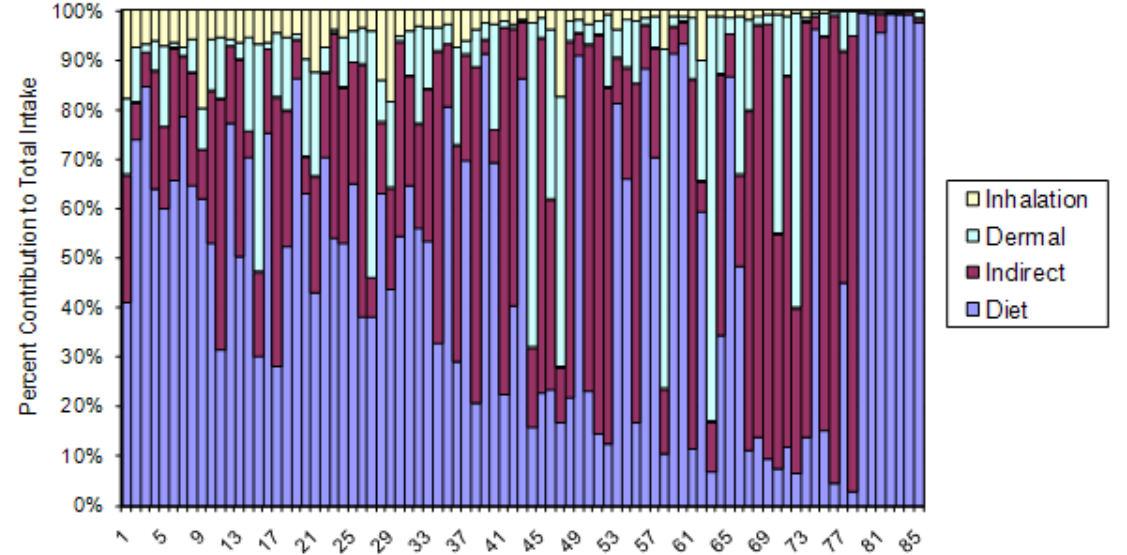
Figure 4. The contributions of inhalation, dermal absorption, indirect ingestion, and dietary ingestion to aggregate intake of cis -permethrin in CTEPP-OH (n =